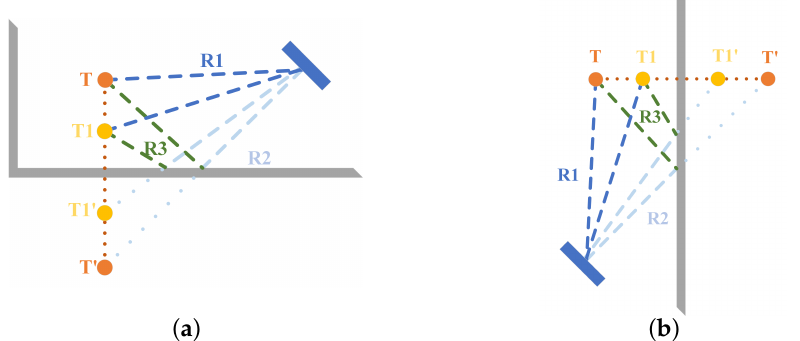
Figure 5. Radar signal reflection paths. ( a ) Side view of the indoor environment. ( b ) Top view of the indoor